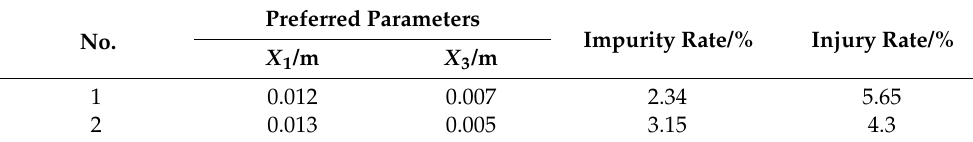
Table 7. Results of